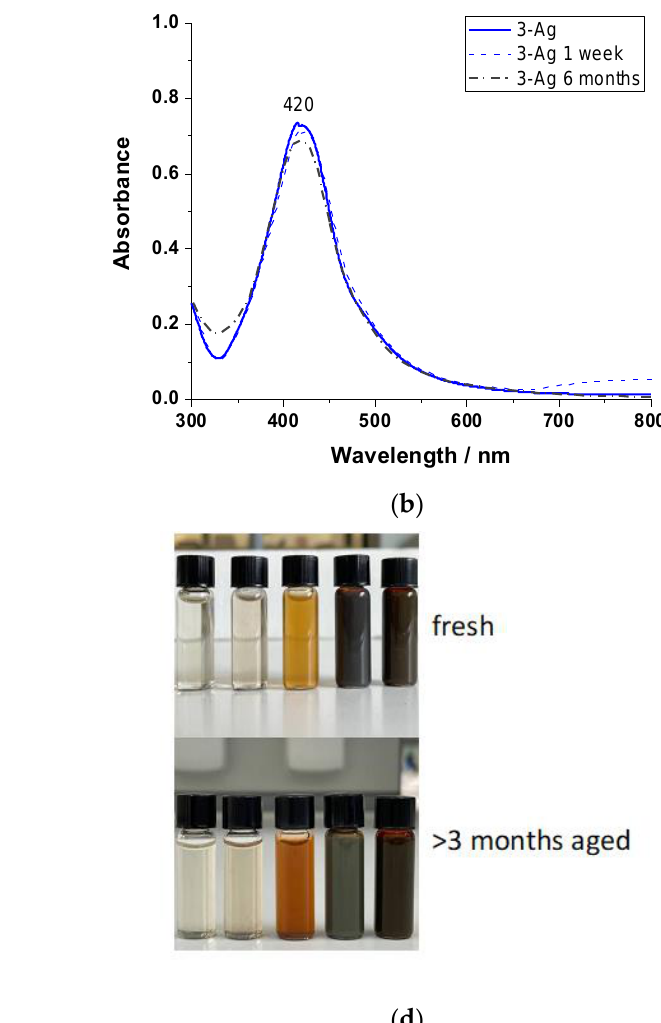
Figure 1. UV-visible spectra of fresh (solid) and aged (dashed, 1 week and 6 months) solutions of colloidal silver synthesized and stabilized by ( a ) CS and TA (2-Ag) and ( b ) by CS, glutaraldehyde (GA) and TA (3-Ag); ( c ) control solutions: silver precursor (AgNO 3 ), chitosan (CS), tannic acid (TA) and silver synthesized and stabilized only by CS (1-Ag), by CS and TA (2-Ag). Photos on the panel ( d ) correspond to fresh (upper) and 6-months-aged (bottom) visual appearances of control and colloidal solutions (from left to right): CS (1), CS/GA/TA (3), CS/AgNPs (1-Ag), CS/TA/AgNPs (2-Ag), CS/GA/TA/AgNPs (3-Ag).